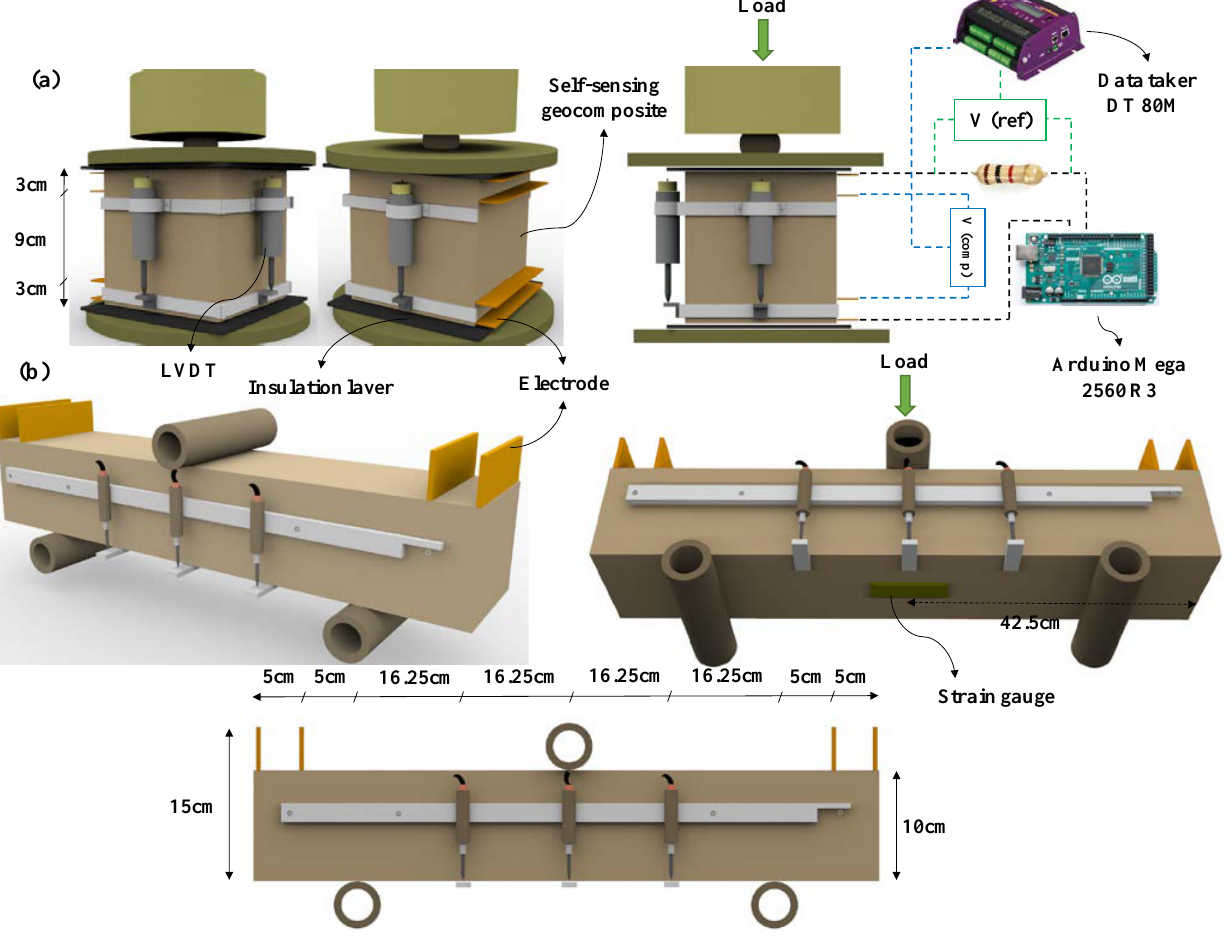
Figure 5. Test setup and electrode configuration: ( a ) compression, ( b ) flexural.